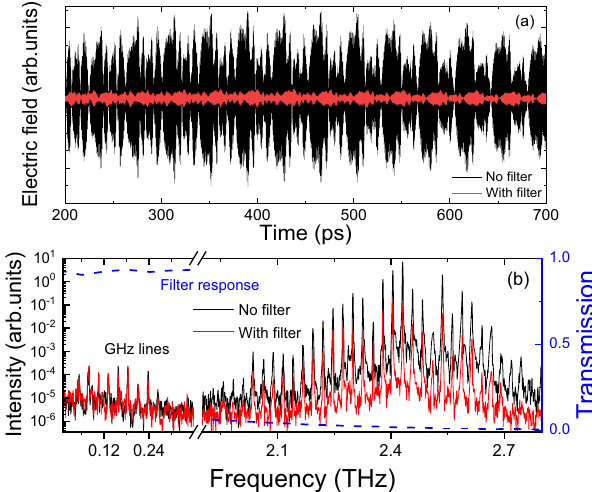
Fig. 1 Temporal and spectral response of mmWave generation from QCL 1 . a Time-resolved electric fi eld from injection seeded QCL with (red) and without (black) the low-pass fi lter. Electric fi eld oscillations of the laser emission are not visible owing to the long temporal scan. b Intensity spectrum of emission from QCL 1 with (red) and without (black) the low pass fi lter. The QCL is driven in pulsed mode (10% duty cycle) and at a fi xed heat sink temperature of 10 K. The THz emission is centred around 2.4 THz. mmWave generation is clearly observed. The fi lter (blue curve) removes an order of magnitude of the intensity of the THz emission but does not change the mmWave emission. This unambiguously illustrates the mmWave emission is from the QCL and not an artefact of the detection technique.